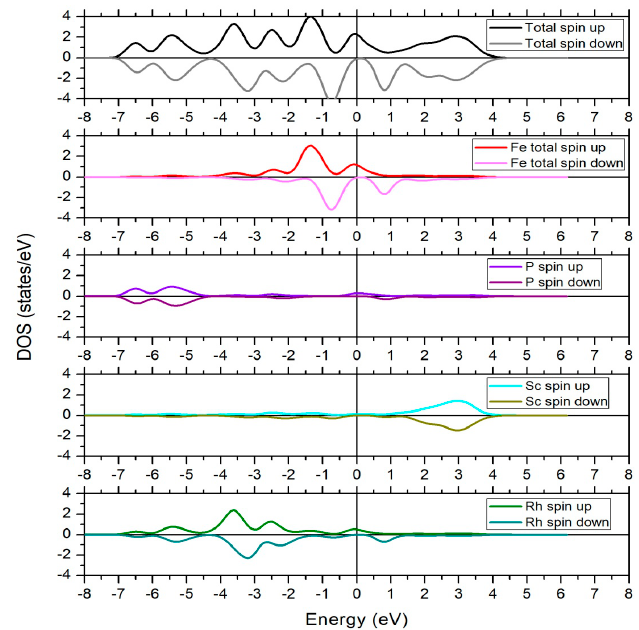
Figure 6. Total density of states (TDOS) and partial densities of states (PDOSs) for ScFeRhP.